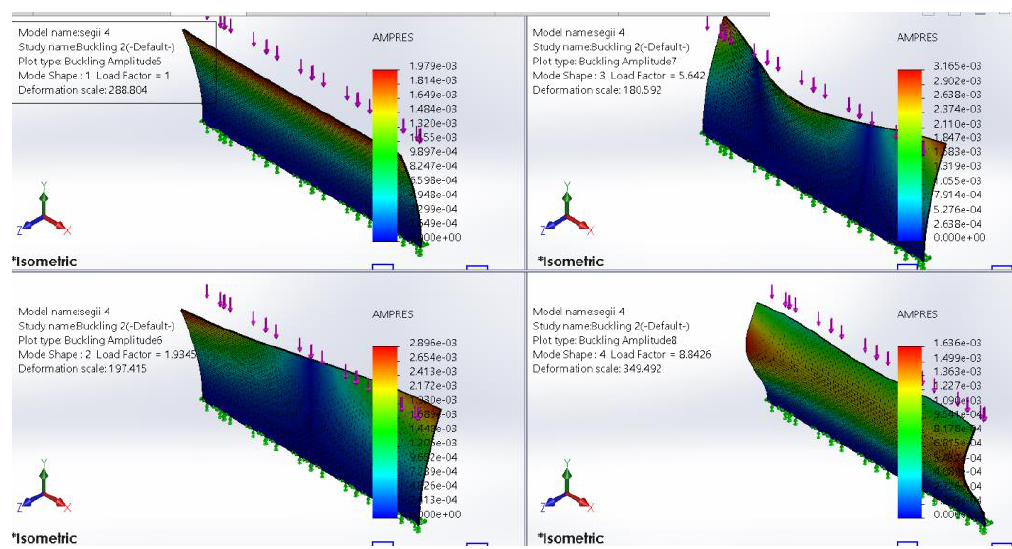
Figure 34: Buckling characteristics of the cross honeycomb